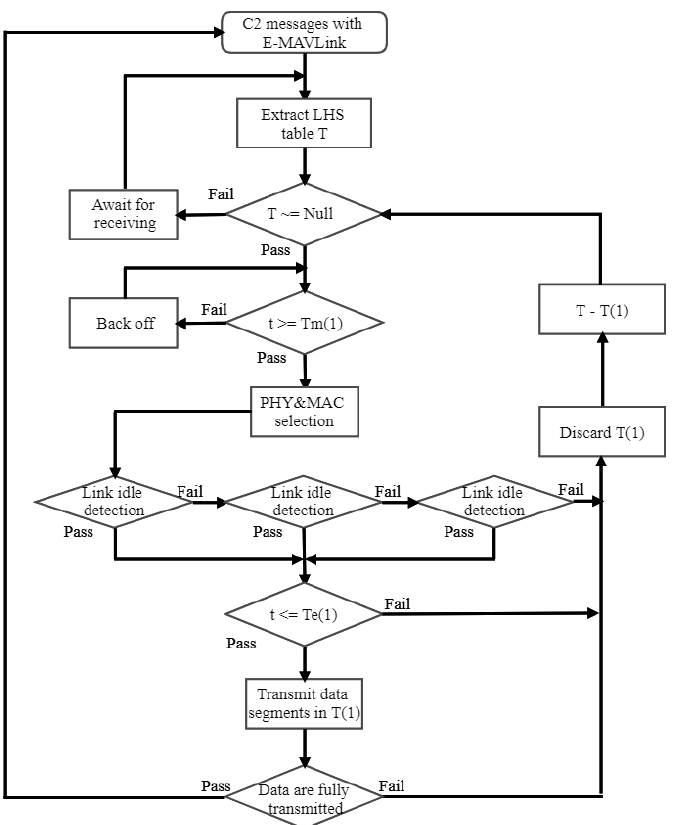
Figure 4. Enhanced MAC protocol enabled with the sensing before transmission scheme where the maximum re-sensing time R =